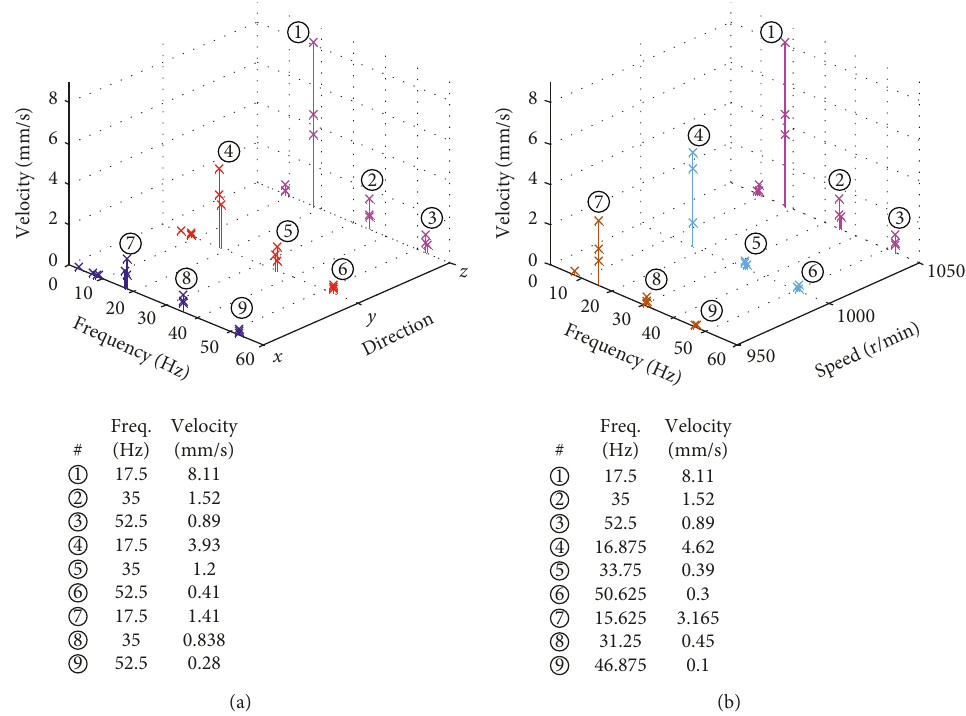
Figure 4: The velocity spectrum of P1: (a) No. 1 compressor operating at 1050RPM; (b) in the z direction.